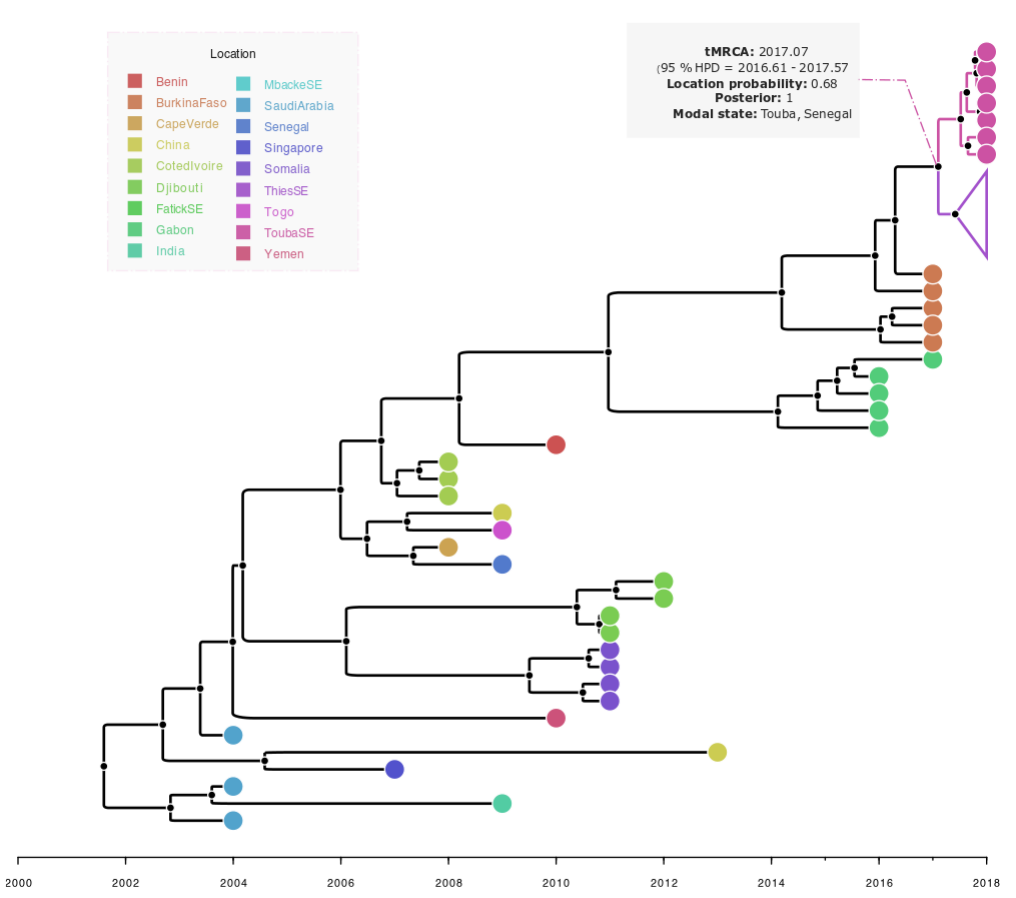
Figure 6. Bayesian discrete phylogeography of dengue—3 strains isolated in Touba in 2018. Touba’s strains (ToubaSE) grouped in a monophyletic cluster with sequences from Thi è s (ThiesSE) (Collapsed in purple).